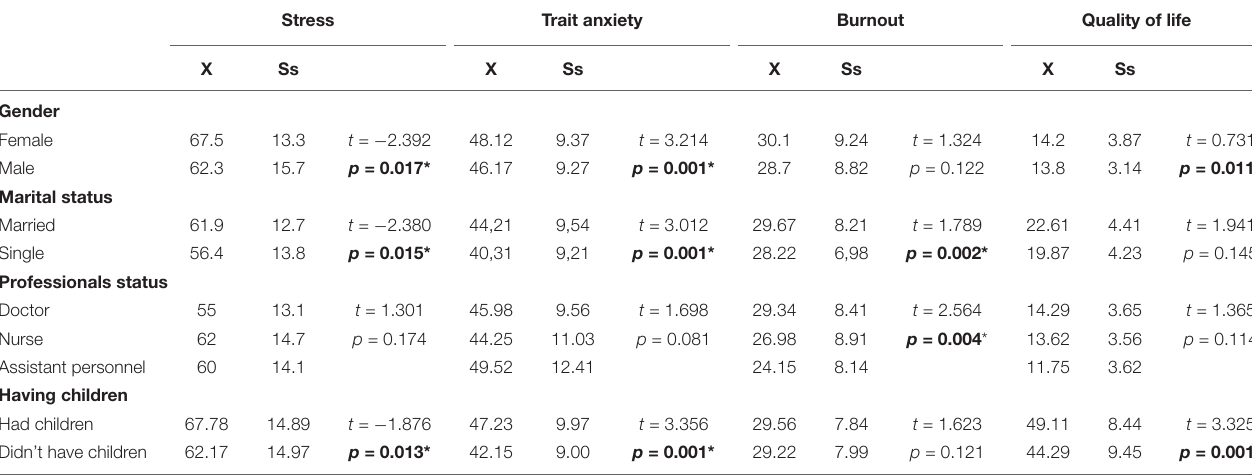
TABLE 4 | The differences between the stress, trait anxiety, burnout, and quality of life mean scores of healthcare professionals. Stress Trait anxiety Burnout Quality of